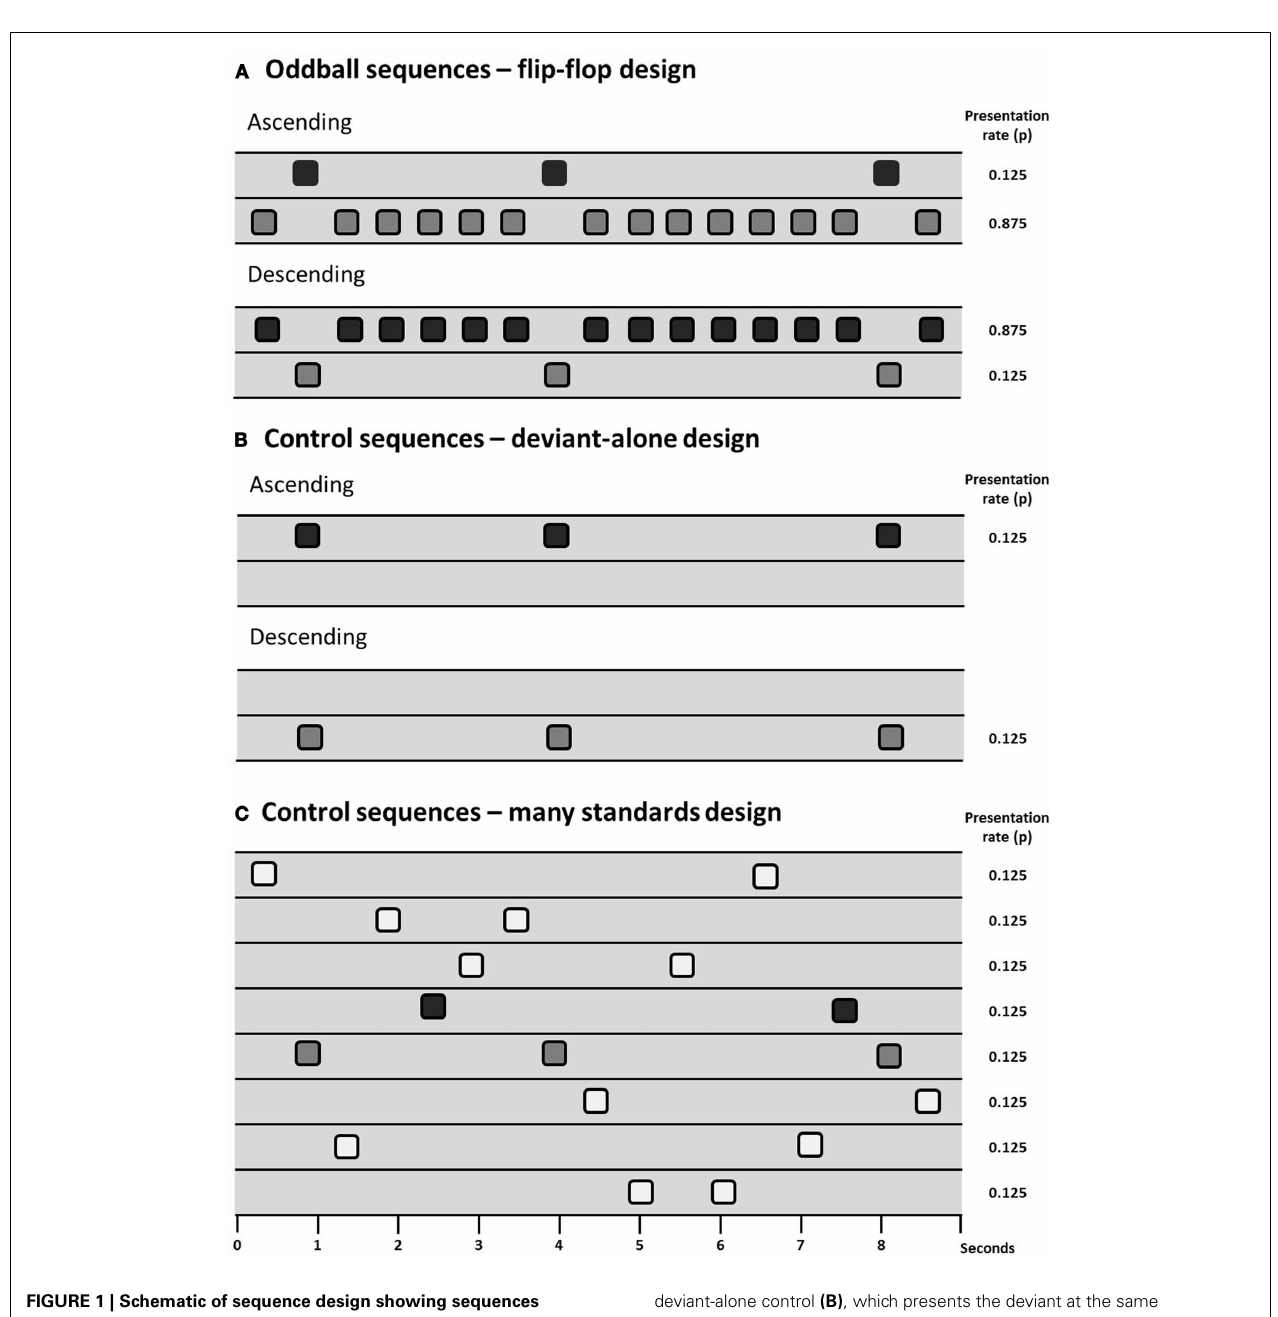
FIGURE 1 | Schematic of sequence design showing sequences with deviants presented at a probability of 0.125 (1/8), two oddball sequences are presented in a flip-flop design (A), controlling for the physical characteristics of the stimuli . Differential adaptation can be controlled for through the use of a